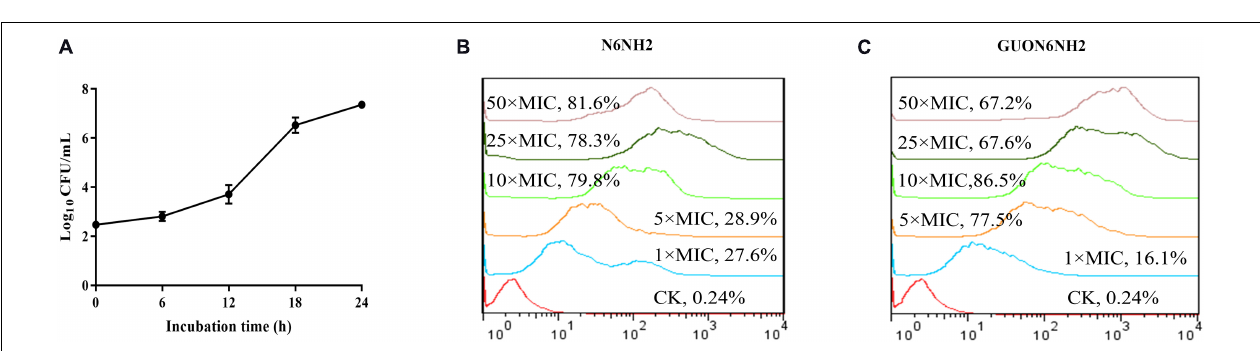
FIGURE 4 | Effects of N6NH2 and its derivatives on the cell morphology and ultra-structures of E. tarda. Bacteria in mid-logarithmic growth phases were treated with peptides or antibiotic at 4 × MIC for 2 h. (A) SEM images of E. tarda cells treated with peptides or norfloxacin. N6NH2, V112N6NH2, and GUON6NH2 induced some protrusions on the cell surfaces, but DN6NH2 and norfloxacin hardly changed the bacterial cell structures. (B) TEM images of E. tarda cells treated with peptides or norfloxacin. Deformed cell morphology, leakage of contents and heterogeneous cytoplasmic electron density were observed in bacterial cells with peptides; there was no changes in norfloxacin-treated cells.